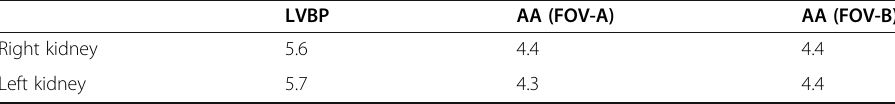
Table 3 Intra-assay coefficients of